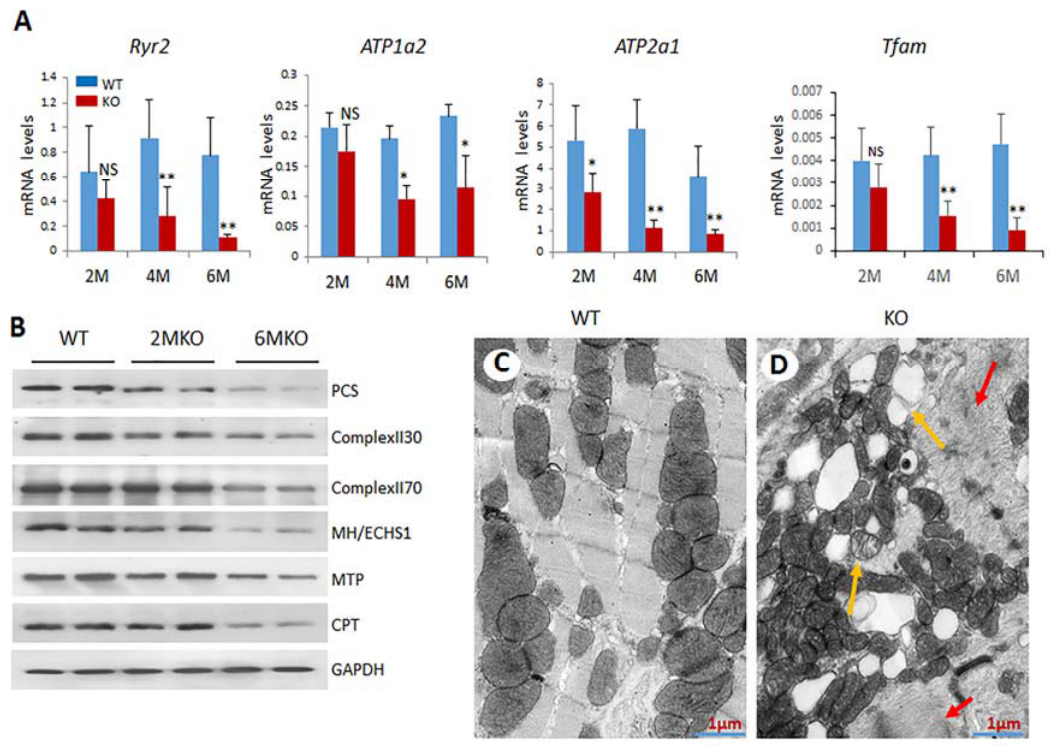
Figure 3. csPIMT − / − hearts show significant mitochondrial damage. ( A ) Quantification of mRNA levels of Atp1a2, Atp2a1, Ryr2 and Tfam genes. Each group was analyzed using 5 different mice (assayed individually) and the values are expressed as the mean ± SD. * p < 0.05, ** p < 001, NS: not significant; ( B ) Western blot showing protein levels for PCS (palmitoyl ‐ CoA synthetase; 62 Kda), complex II30 and 70, MH/ECHS1 (mitochondrial enoyl ‐ CoA hydratase; 31 Kda), MTP (mitochondrial trifunctional protein; 100 Kda) and CPT1 α (carnitine palmitoyltransferase; 88 Kda)). The protein extracts were prepared from 5 hearts pooled together. The protein expression of each gene was normalized to GAPDH. Percent decrease as compared WT controls were as follows: PCS, 67%; complex II30 and 70, 28% and 38%; MTP, 26%, and CPT, 42%; ( C , D ) display the electron micrographs of 6 ‐ month csPIMT fl/fl and csPIMT − / − mouse hearts. Red arrows in D indicate abnormal sarcomeres and H zone absent. Yellow arrows point to lipid droplets and damage in mitochondria.